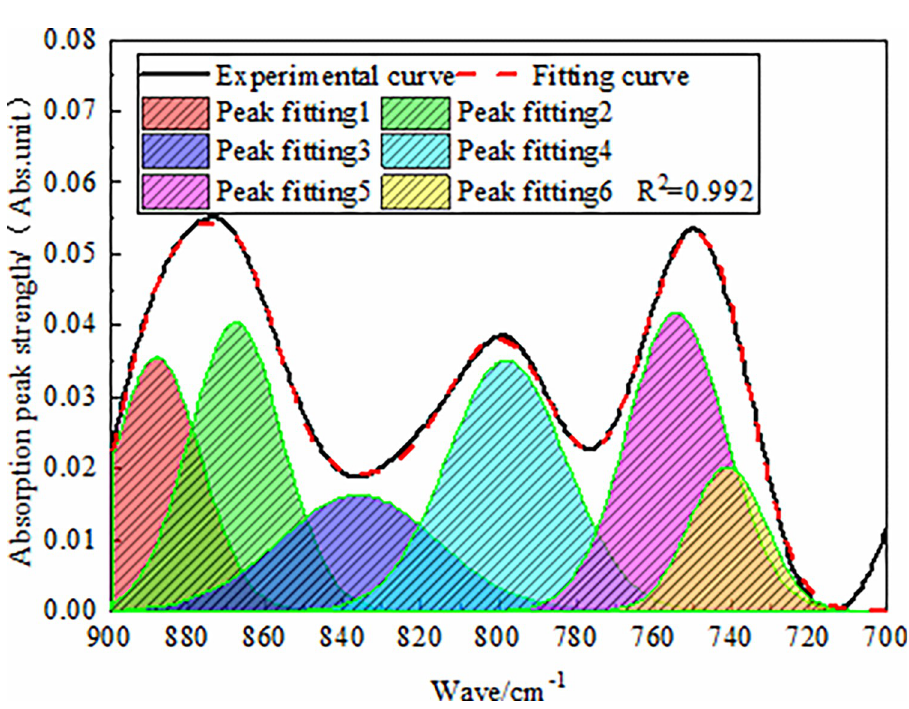
Fig 2. FT-IR fitting spectra of anthracite in 900–700 cm -1 band.